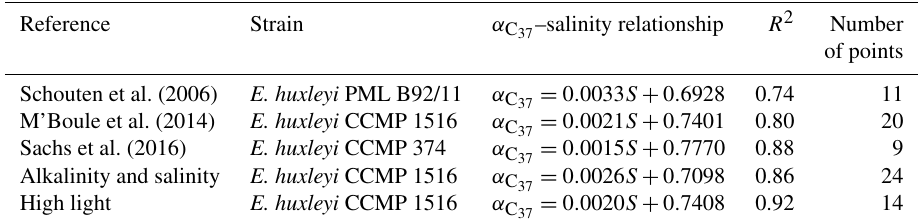
Table 2. Linear regression equations for hydrogen isotope fractionation–salinity ( α C growing different strains of Emiliania huxleyi